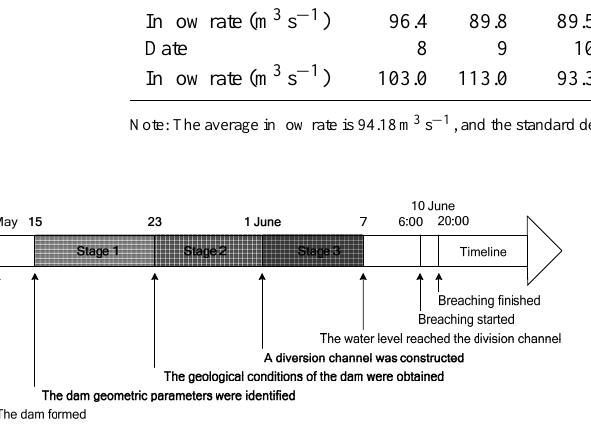
Fig. 4. The timeline and three stages of decision making